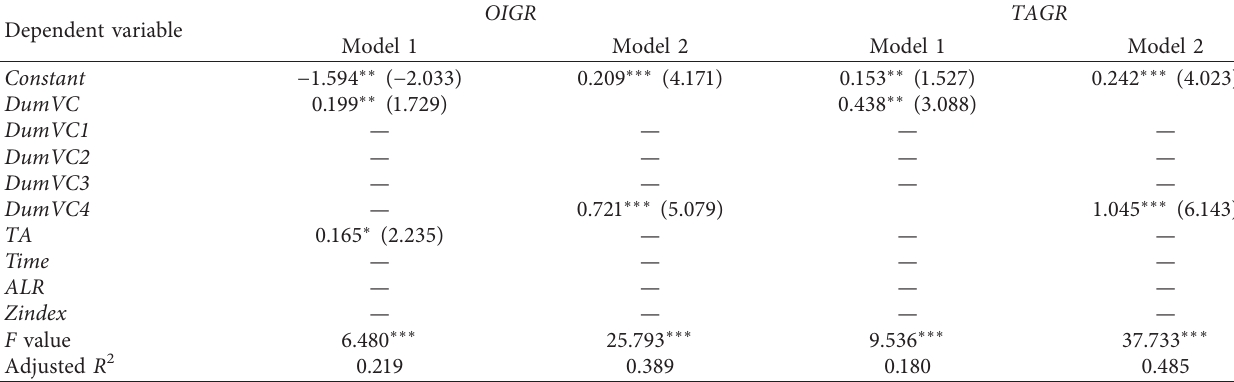
Table 4: Effect of venture capital on the development ability of